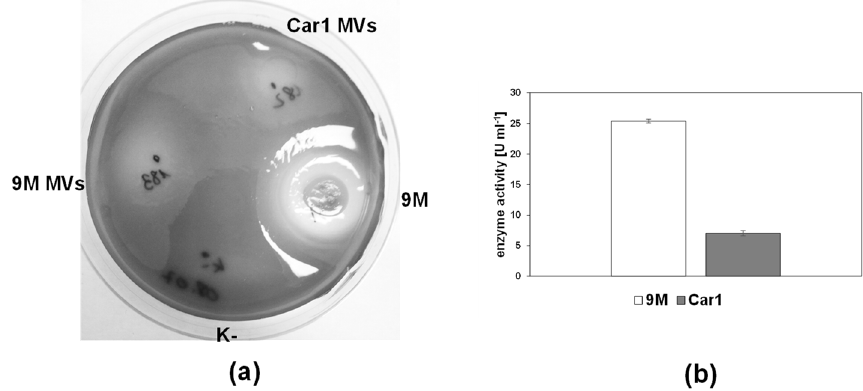
Figure 7. Assessment of pectinase degrading enzymes activity in the MVs from P. zantedeschiae 9M and P. odoriferum Car1. ( a ) The pectinase plate test on the M63 medium supplemented with 0.4% PGA. P. zantedeschiae 9M strain was used as a positive control. Clear halo zones indicate pectate degradation. ( b ) The DNS assay of the MVs samples. The assay measures the presence of reducing sugars. One unit (U) is equivalent to one μ mol of product released per min. Bars indicate a standard deviation of the mean, n = 3, p < 0.05.